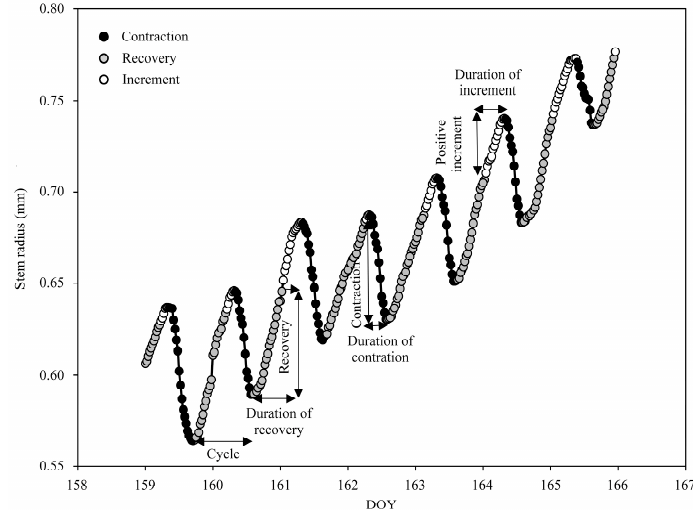
Figure 2. Cycles of stem radius of Larix principis-rupprechtii and its three phases: contraction; recovery, and; increment. The values are the mean stem radius of four trees (DOY 159–166, 2015).